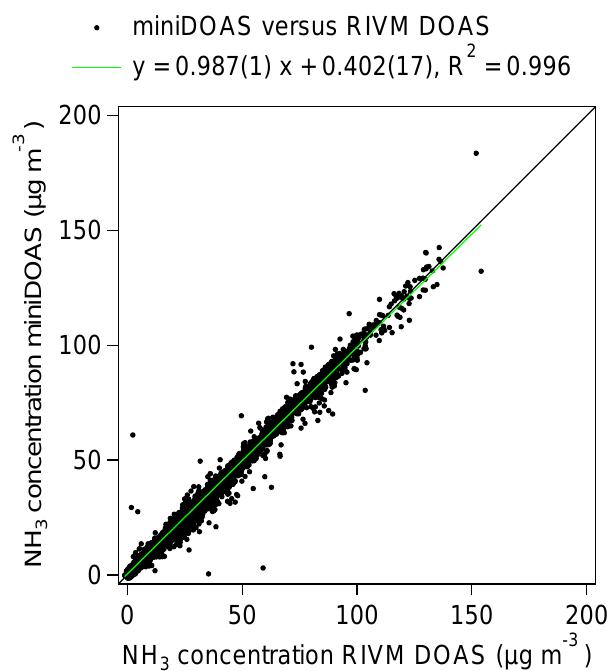
Fig. 16. Ammonia concentration values of the miniDOAS instrument versus RIVM DOAS concentration values. The miniDOAS 1-min concentrations have been converted to 5-min values to facilitate the comparison with the 5-min concentrations of the RIVM DOAS instrument. The number of data points used in this plot is 13903. The results of both instruments show a high correlation ( R 2 =0.996).